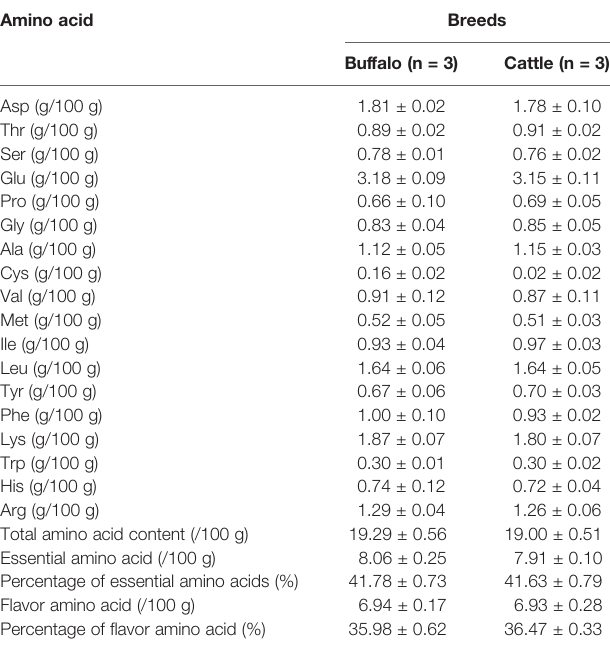
TABLE 3 | Amino acid analysis results of longissimus dorsi muscle sample. Amino acid Breeds Buffalo (n = 3) Cattle (n = 3) Asp (g/100